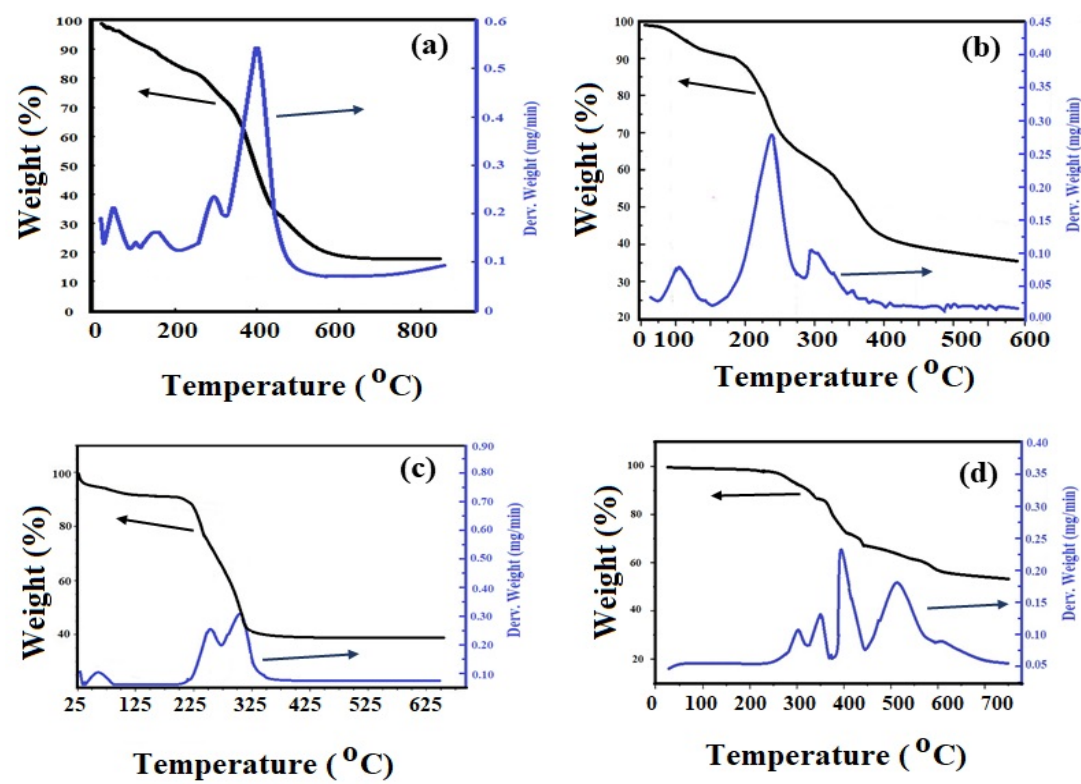
Figure 3. Thermogravimetric and differential thermogravimetric (TGA-DTG) thermograms of ( a ) HCh, ( b ) low chitosan (LCH)-TH2, ( c ) medium chitosan (MCh)-TH2, and ( d ) HCh-TH2 grafts.